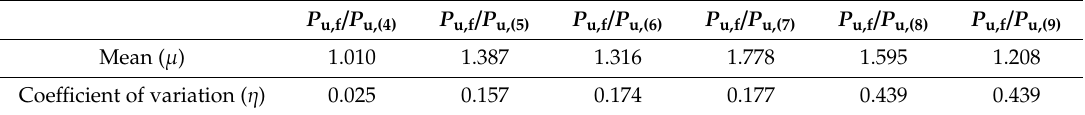
Figure 12. Comparison of the predicted bearing capacities with the FE example results and the test results: ( a ) comparison of the predicted bearing capacities with the FE example results; ( b ) comparison of the predicted bearing capacities with the test results. Table 4. Comparison between the calculated results of the 45 finite element examples and equations.